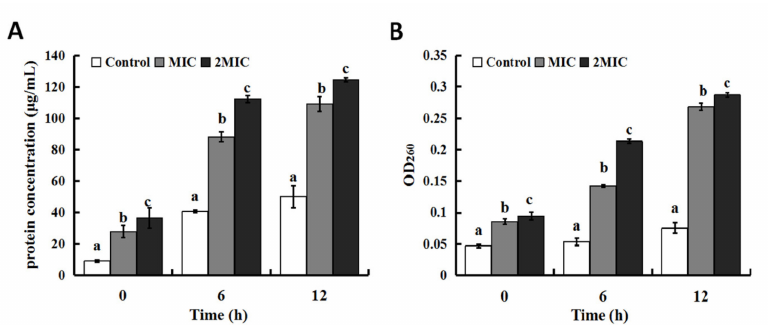
Figure 3. E ff ect of the MEO on the release of S. aureus cells constituents. ( A ) Leakage of protein from the membrane of S. aureus treated with MEO; ( B ) Release of intracellular nucleic acids from S. aureus treated with MEO. Di ff erence letters means statistical di ff